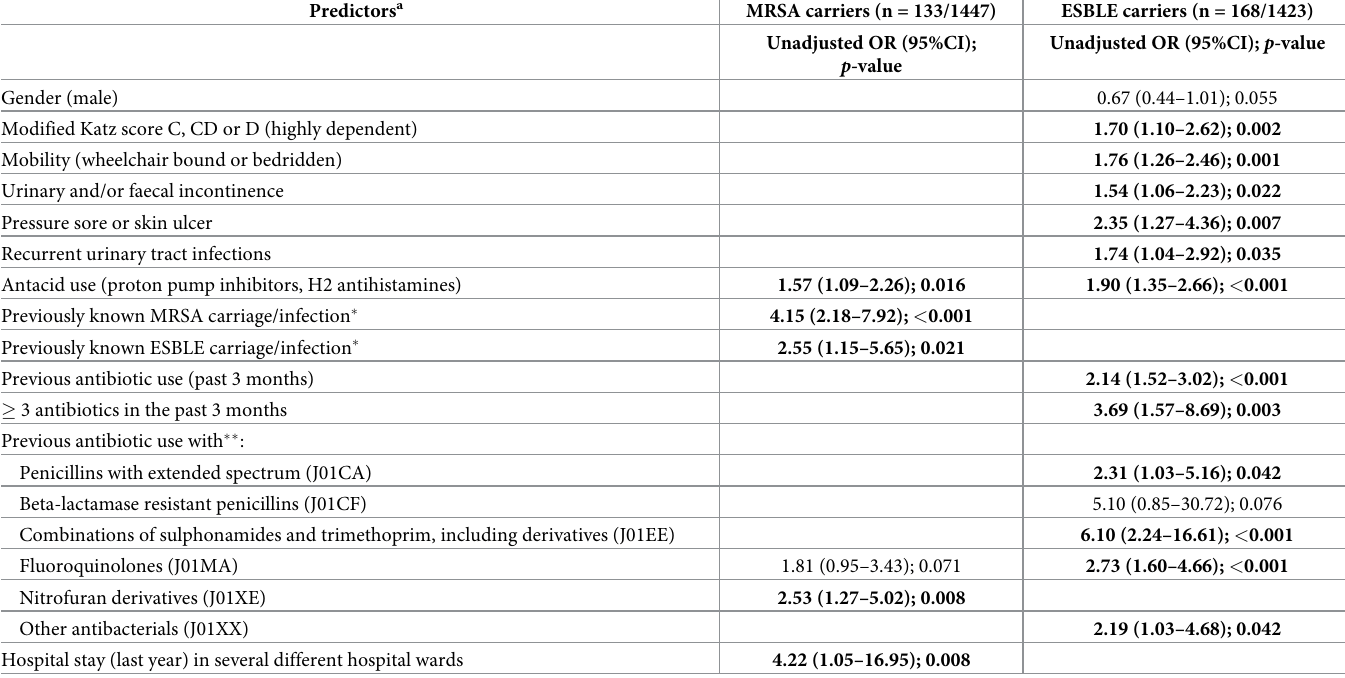
Table 4. Risk factors for colonization with MRSA and ESBLE among a random sample of residents screened within 29 Belgian nursing homes, 2015: Results from univariate analysis. Predictors a MRSA carriers (n =